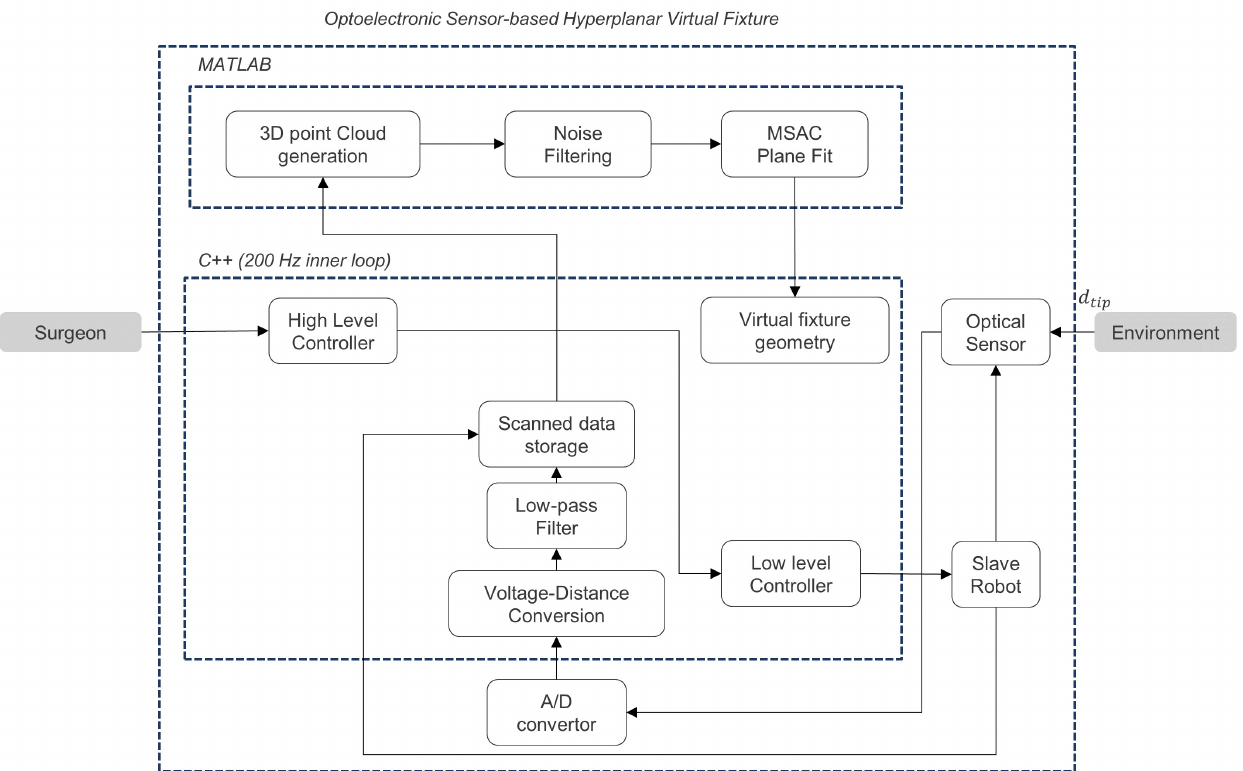
Figure 3. Schematic block diagram of the optoelectronic sensor-based algorithm for hyperplanar VF geometry